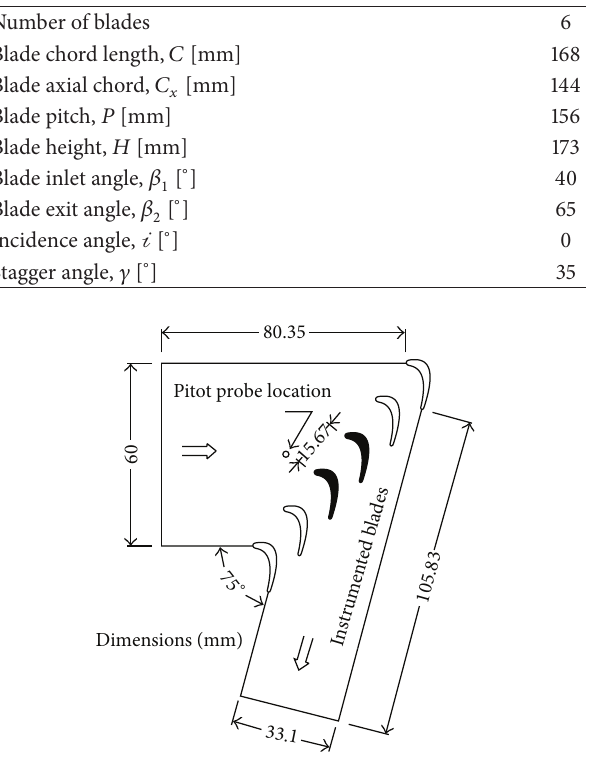
Figure 2: Schematic diagram of test